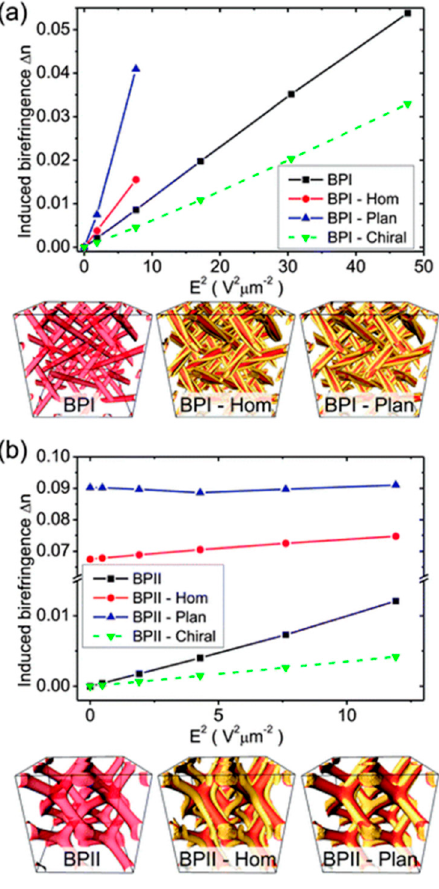
Figure 12. Kerr response of the templated blue phases with memorised blue phase surface anchoring, homeotropic surface anchoring, and planar degenerate anchoring. Plot of the induced birefringence for the different structures of ( a ) templated blue phase I and ( b ) templated blue phase II. For comparison, in ( a ) and ( b ), the induced birefringence calculated for templated blue phases with memorised blue phase surface anchoring filled with chiral nematic with a pitch = 0.651 mm for the blue phase I (BP I) and 0.590 mm for the blue phase II (BP II) templates (in green, dashed lines) are given. Reprinted with permission from Ravnik et al., Soft Matter , 2015 , 11 , 8417. Copyright (2015) American Chemical Society.